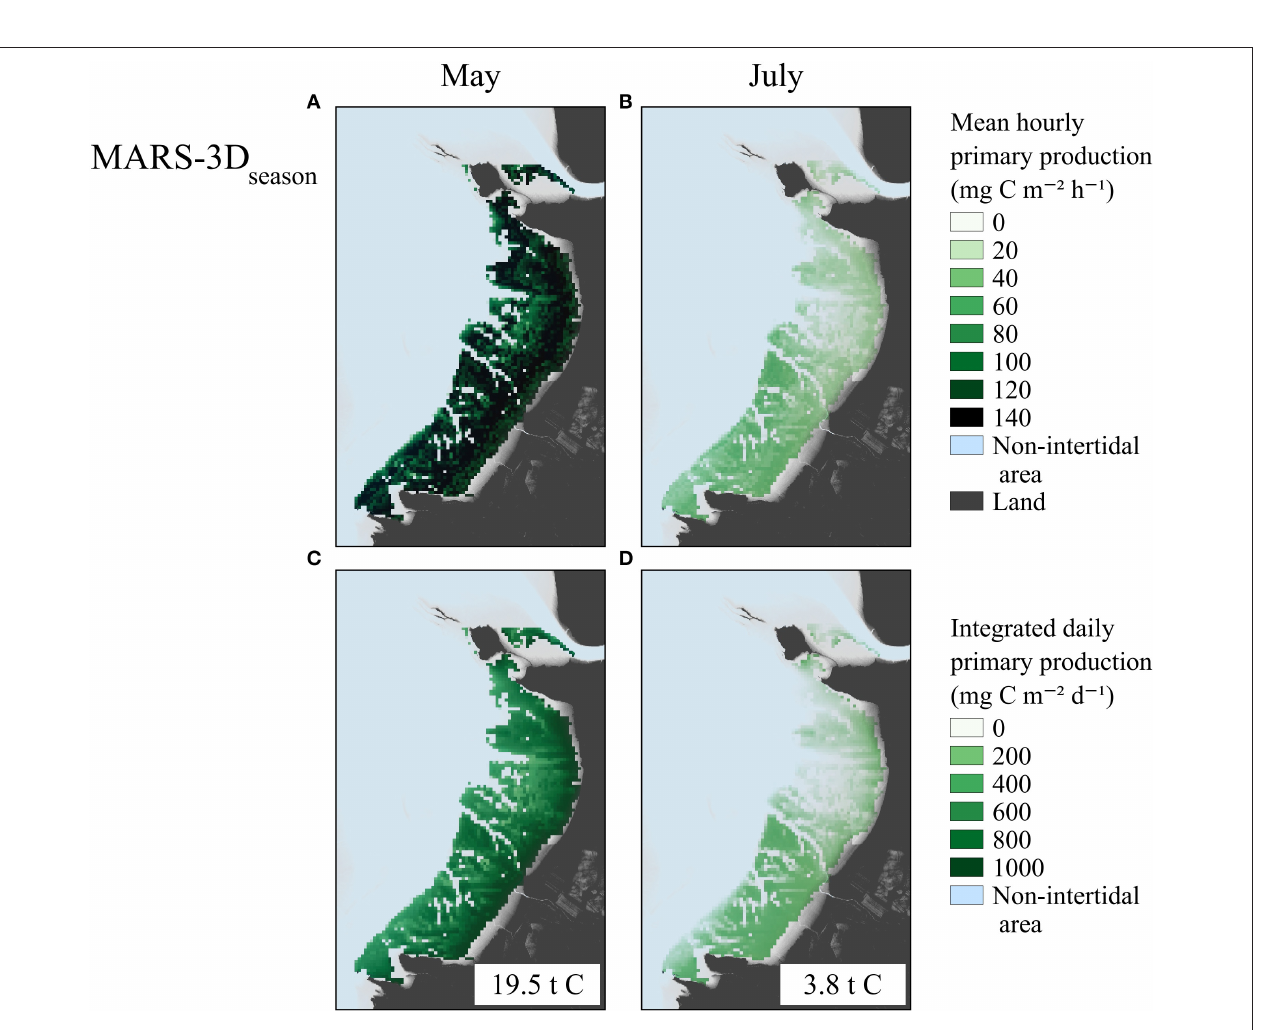
Frontiers in Marine Science |